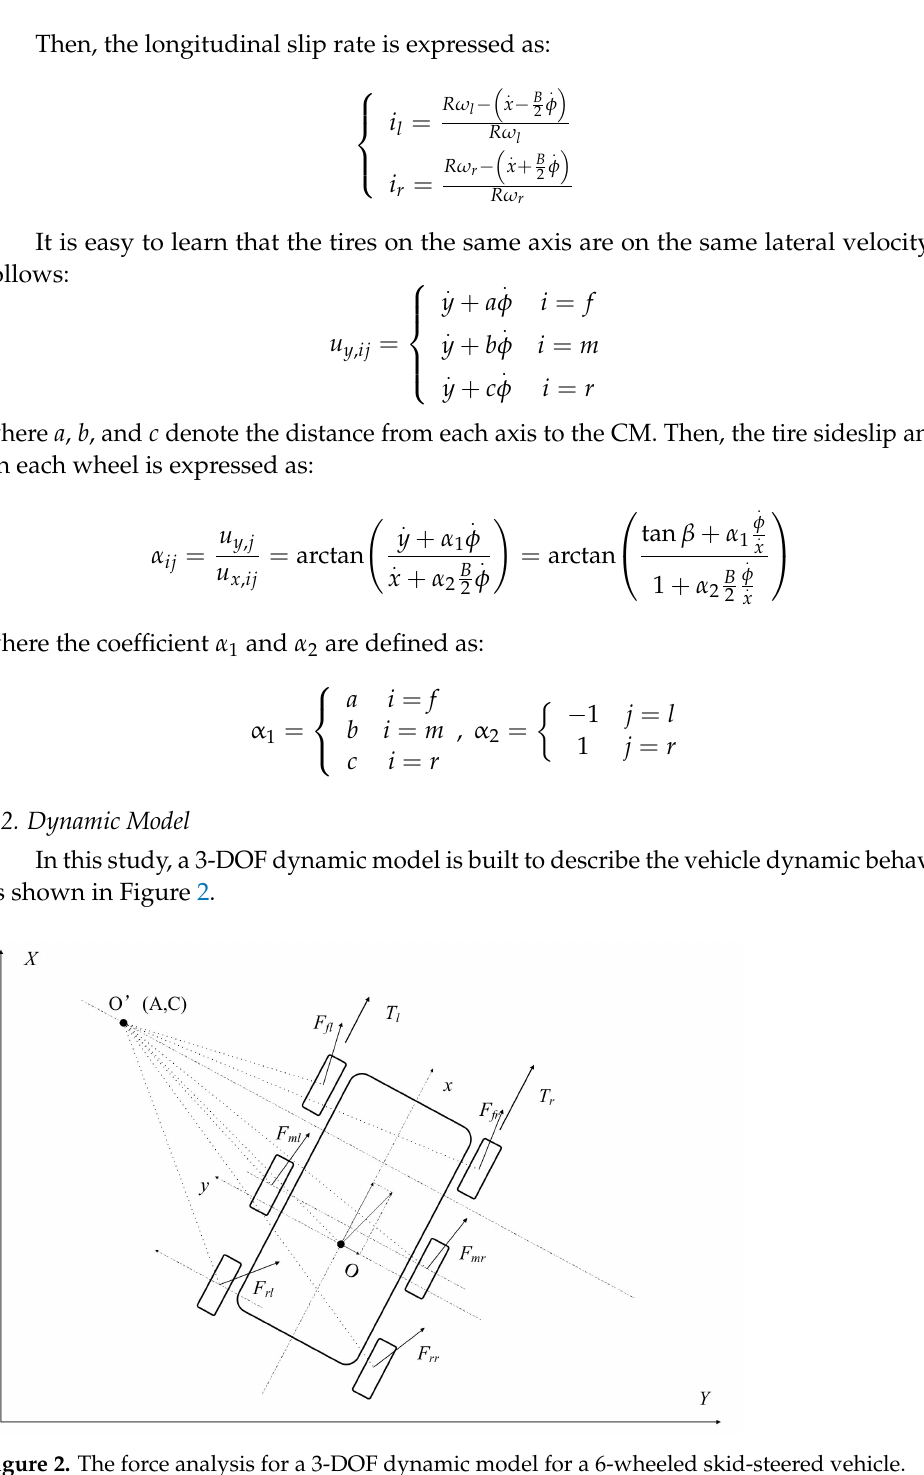
Figure 2. The force analysis for a 3-DOF dynamic model for a 6-wheeled skid-steered vehicle. The coordinate is the same as the coordinate in the kinetic model in Figure 2. The 3-DOF dynamic model is set up as